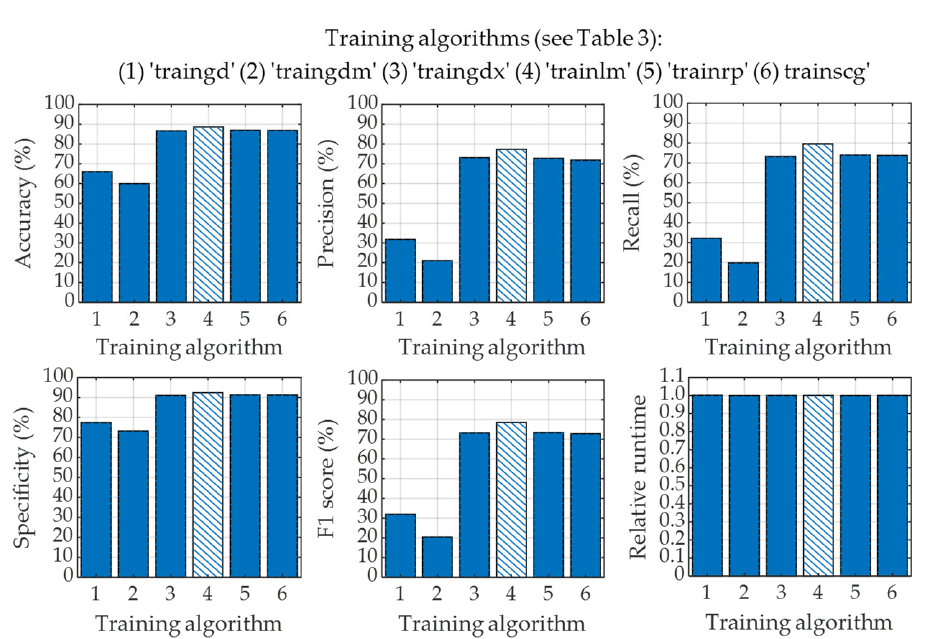
Figure 13. Classification performance for using different training algorithms in LBP ‐ based PRN.